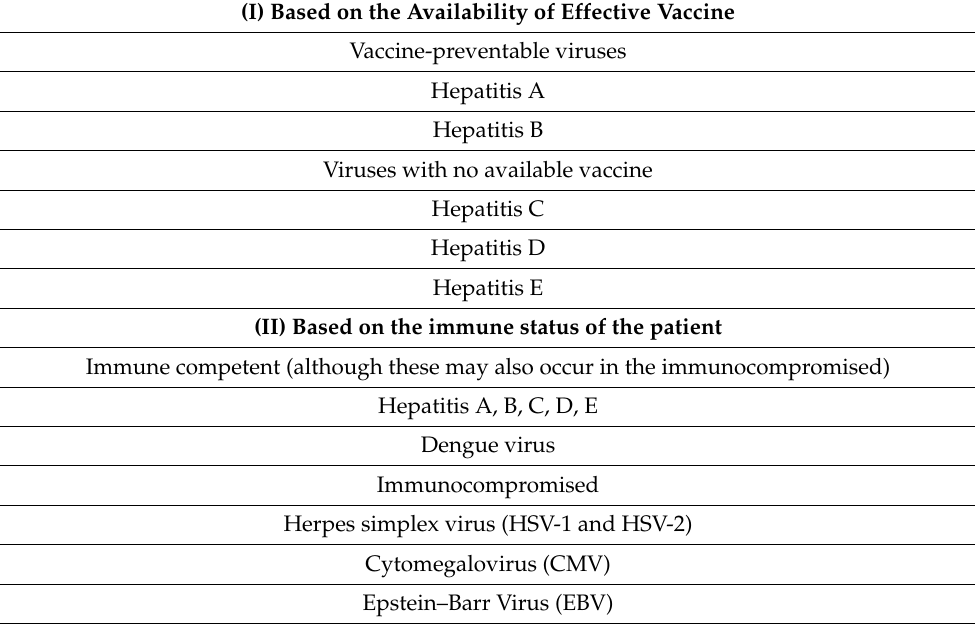
Table 2. Known viral agents which may cause acute liver failure